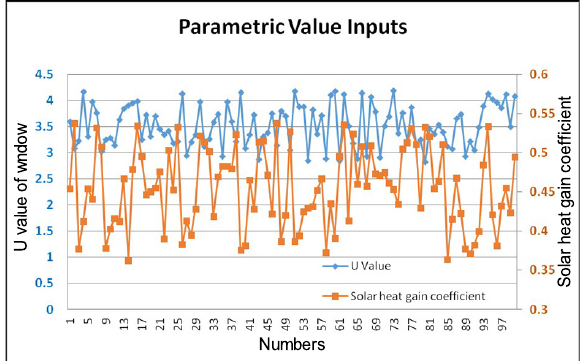
Fig. 6. Change of utilizability and energy saving with varying parameter